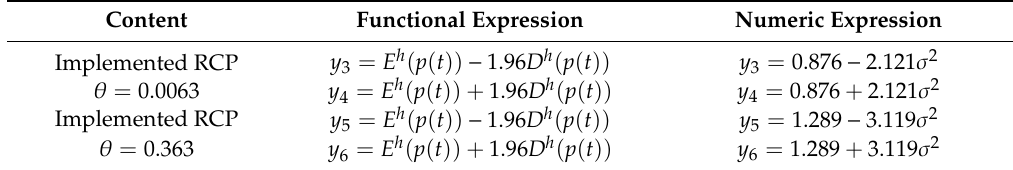
Table 4. The water pollution control e ff ect under the implemented RCP.